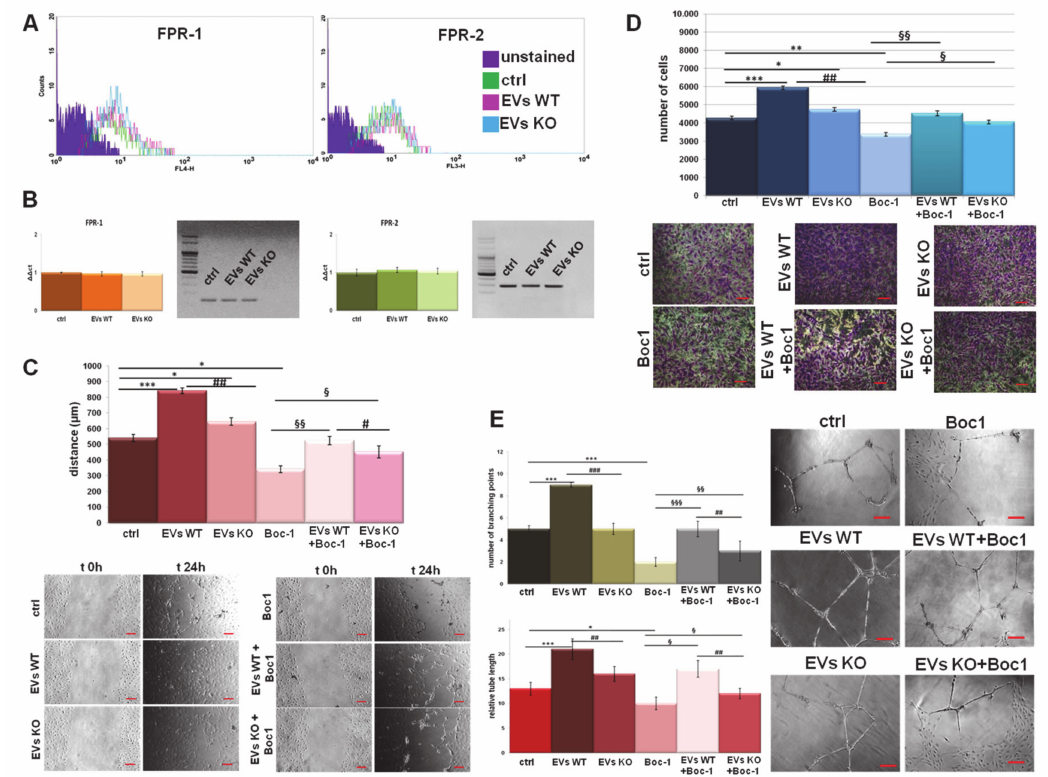
Figure 4. EVs interact with FPRs on endothelial cells. ( A ) Expression of FPR-1 and FPR-2 on HUVEC cells was analyzed by flow cytometry. The violet areas in the plots are relative to unstained fibroblasts. FPR-1 and FPR-2 signals are showed in green for ctrl, in pink for WT EVs and in light blue for ANXA1 KO EVs treated cells for 24 h. ( B ) RT-PCR for FPR -1 and FPR -2, mRNA expression measured on levels of HPRT 1. Values refer to the same experimental points of flow cytometry analysis are expressed using the delta-delta Ct method to derive relative fold change. It is also shown the electrophoresis of the FPR -1 and FPR -2 RT-PCR products on 2% agarose gel stained with ethidium bromide. Results of HUVEC ( C ) migration and ( D ) invasion in presence of WT and ANXA1 KO EVs with or without Boc-1 (100 µ M) with relative bright field images. Bar = 50 µ m. ( E ) Representative images of tube formation by HUVEC cells with the related analysis of tube length and number of branches. Bar = 100 µ m. Data represent the mean of four independent experiments ± standard deviation with similar results. * p < 0.05; ** p < 0.01; *** p < 0.001 for treated cells vs. untreated controls; # p < 0.05, ## p < 0.01; ### p < 0.001 for each point of ANXA1 KO MIA PaCa-2 cells vs. WT one; § p < 0.05; §§ p < 0.01; §§§ p < 0.001 for each point of EVs + Boc-1 vs. Boc-1